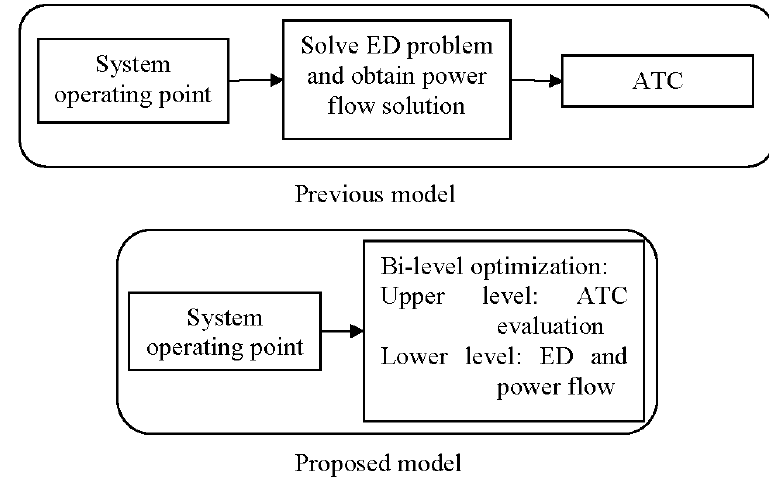
Figure 1. Framework of ATC evaluation of previous and proposed model.